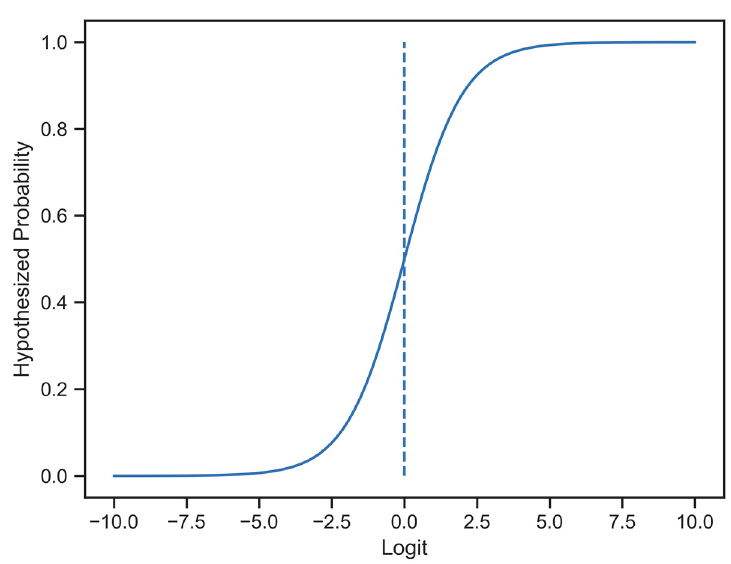
Figure 3. Hypothetical sigmoid function on the coordinate plane.